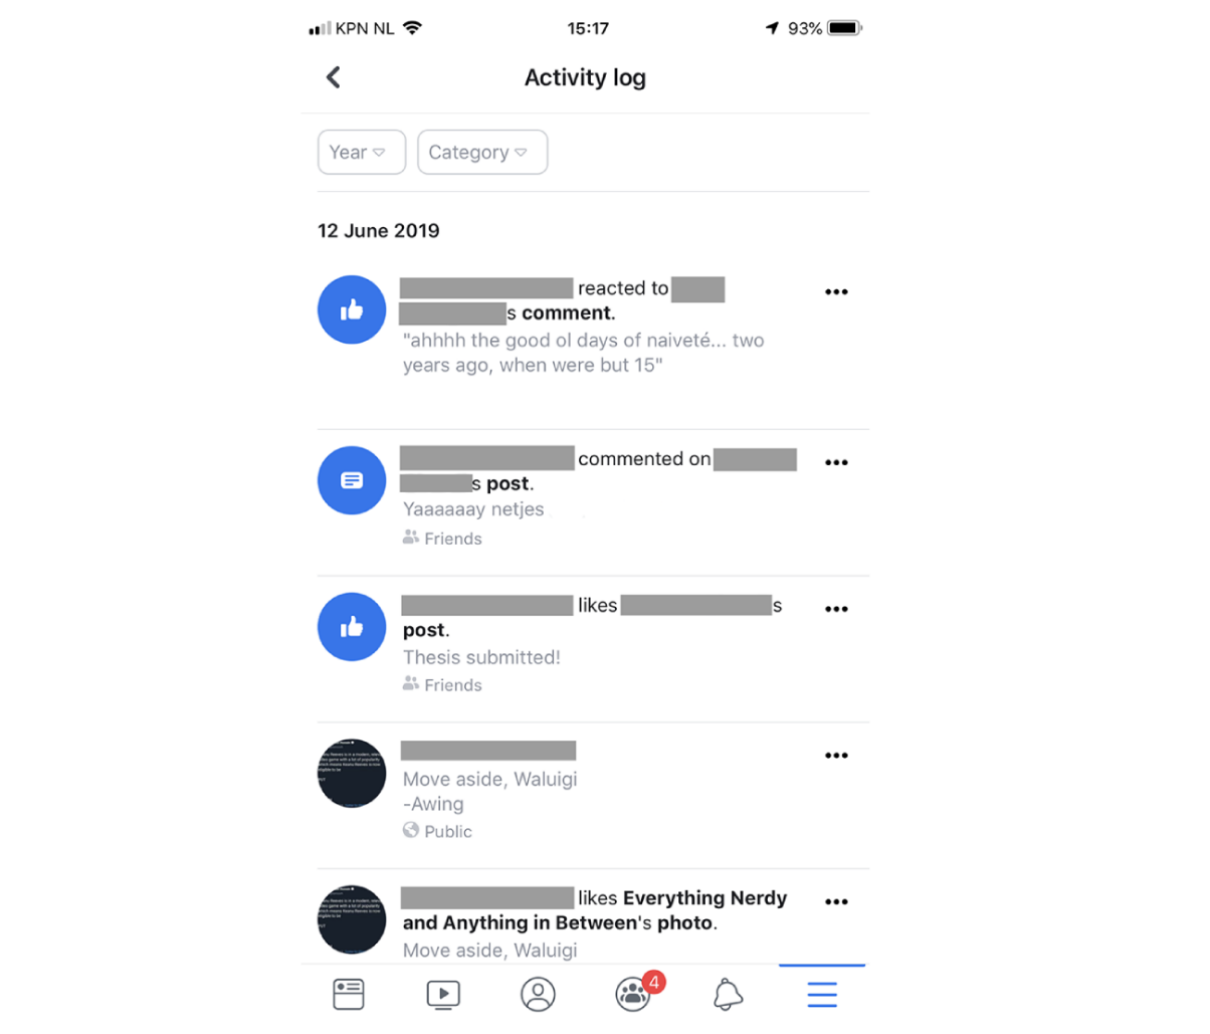
Figure 2. Screenshot from Facebook app illustrating the activity